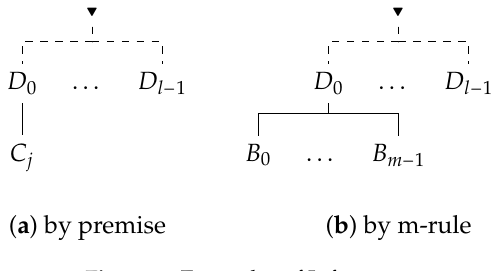
Figure 6. Examples of